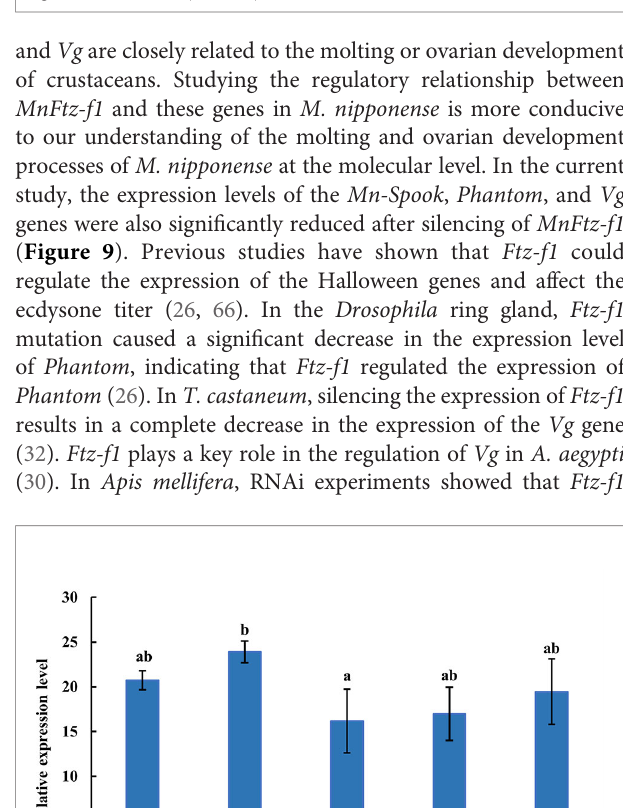
FIGURE 5 | Expression of MnFtz-f1 mRNA in different tissues of M. nipponense . O, ovary; H, heart; G, gill; E, eyestalk; He, hepatopancreas; M, muscle. Statistical analyses were performed by one-way ANOVA. Data (mean ± SEM, n = 6) were expressed relative to the expression of the eukaryotic translation initiation factor 5A (EIF) gene. Bars with different letters indicate signi fi cant differences (P < 0.05).